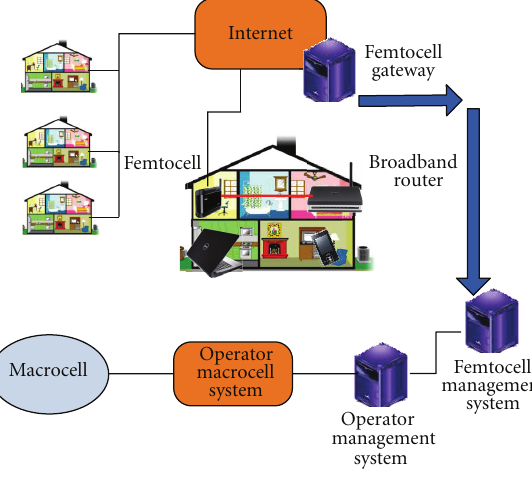
Figure 1: Basic femtocell